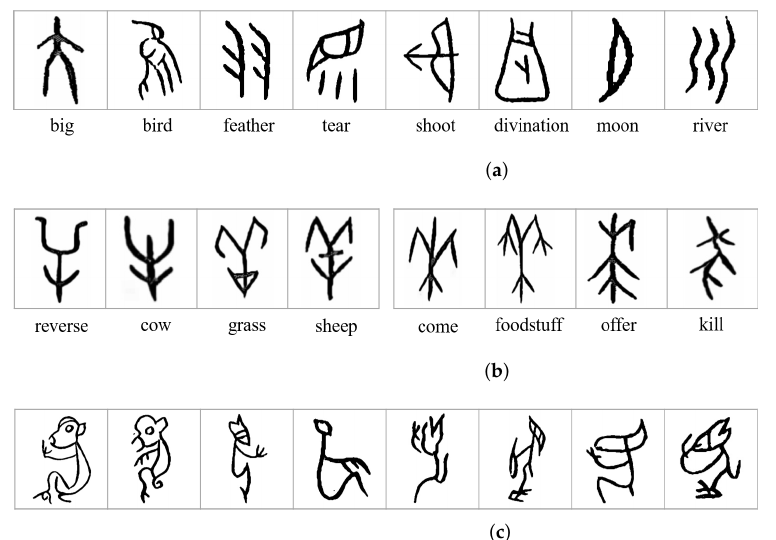
Figure 2. Examples of OBI characters. ( a ) Examples of characters of OBI corresponding to eight commonly used words. ( b ) Eight characters of OBI that have different meanings, but look very similar. ( c ) Eight writing styles of monkey in